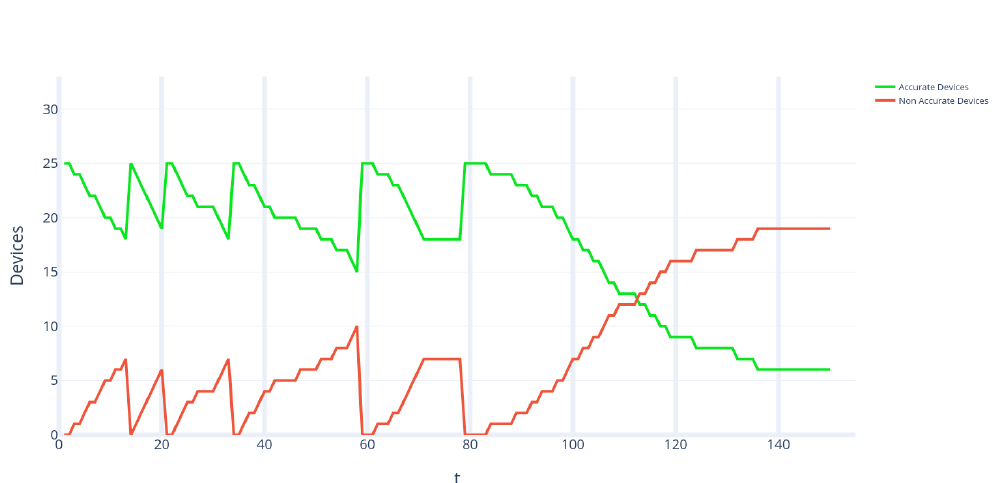
Figure 7. Time evolution of prey and predator populations of simulation 2 of the Lotka Volterra Non Autonomous model proposed in this paper. The predator population (red line) has fluctuations in its population until it reaches equilibrium while the prey population (green line) also has fluctuations in its population due to interaction with predators. In this simulation, human intervention is taken into account; therefore, when NADs are arranged the population of prey increases a lot (e.g., this can be seen in the peaks of both lines) while that of predators drops